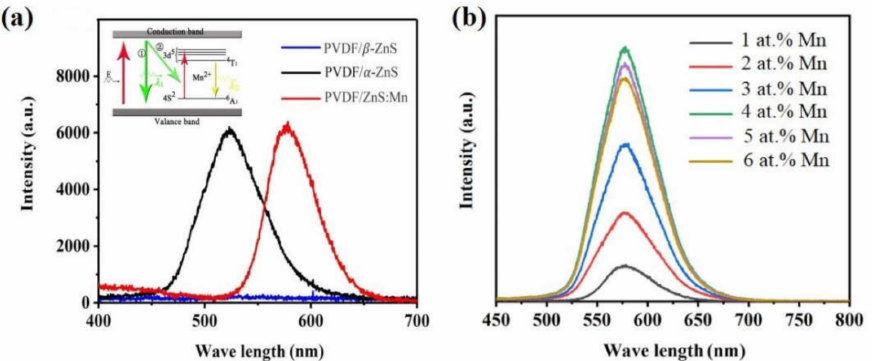
Figure 6. PL spectra of PVDF composite thin-film sensors with ( a ) ZnS or ZnS:Mn; ( b ) ZnS doped with different